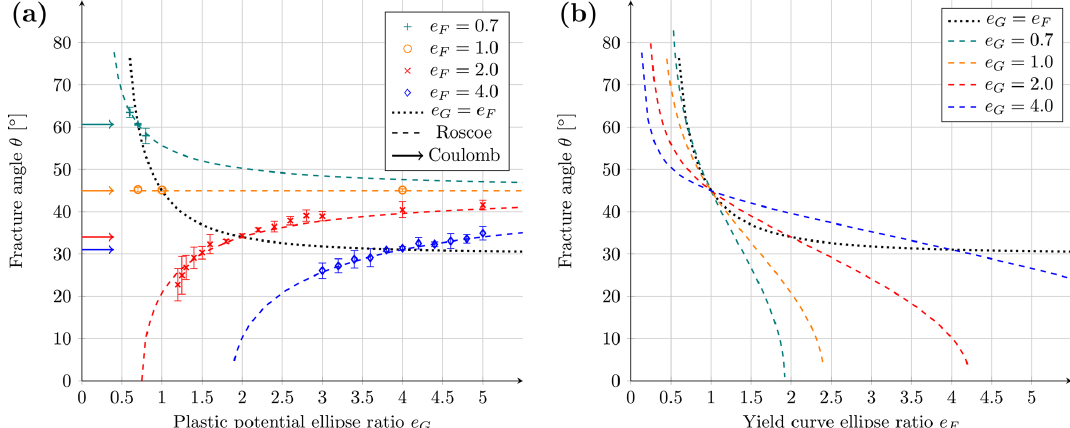
Figure 7. (a) Fracture angles as a function of the plastic potential ellipse ratio e G for different yield curve ellipse ratios ( e F = 0 . 7, 1 . 0, 2 . 0, and 4 . 0). The markers with ranges are the mean and 2 standard deviations of the fracture angles. The dashed lines show the Roscoe angle (Eq. 30). The arrows mark the Coulomb angles as a function of e F , which are constant with respect to e G . Colors indicate the value of e F for lines and markers. The r 2 values between theory and modeled angles for e F = 0 . 7, 2 . 0, and 4 . 0 are 0 . 97, 0 . 95, and 0 . 97. (b) Roscoe fracture angle computed from Eq. (30) as a function of e F with a constant e G , for illustration. As e F changes, both the stress state and the flow rule change (see Fig. 4), resulting in more complex behavior. The dotted black line for the normal flow rule ( e F = e G ) is drawn for reference.